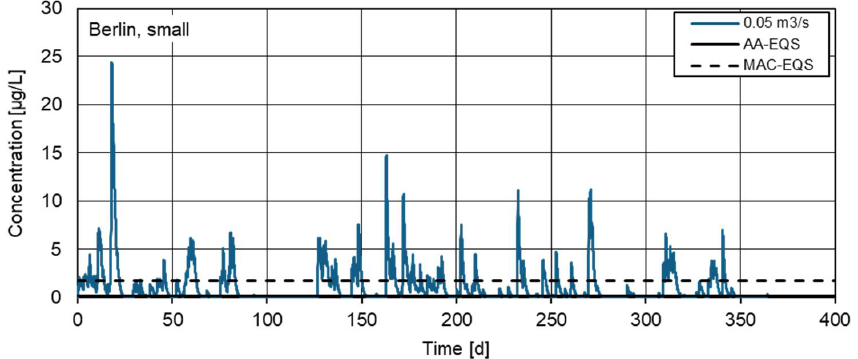
Figure 8. Simulated concentration of diuron in a small brook (0.05 m 3 /s) in Berlin over a period of 1 year.